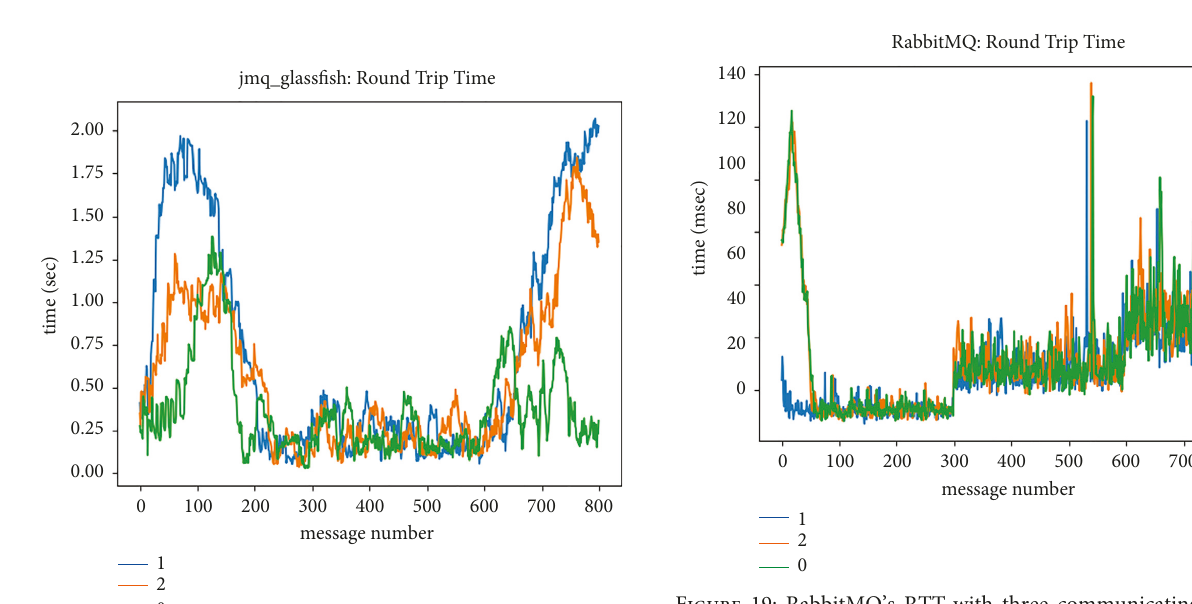
Figure 19: RabbitMQ’s RTT with three communicating process